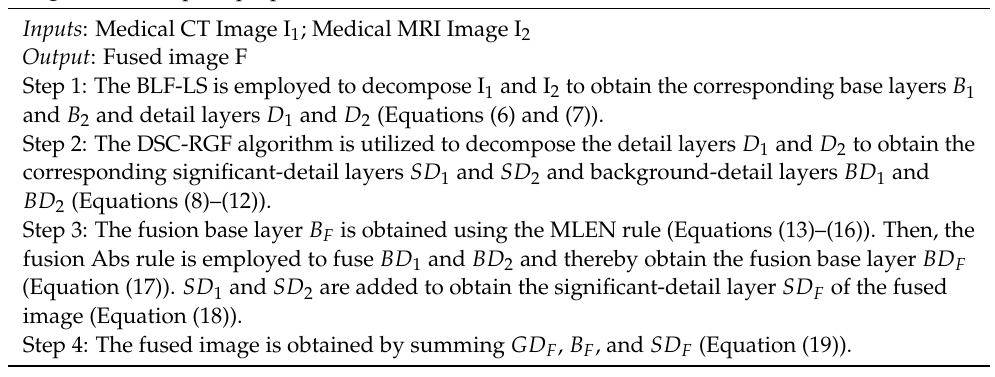
Algorithm 1 Steps in proposed fusion